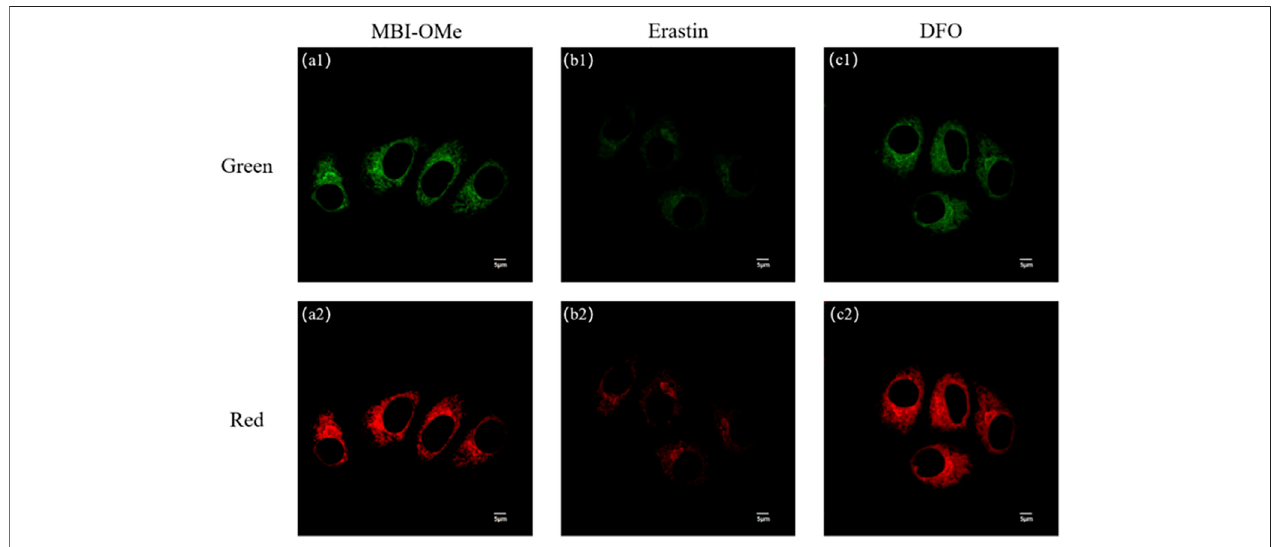
FIGURE 5 | (A) Imaging of MBI-OMe in HepG 2 cells. (B) Cell imaging of MBI-OMe performed after erastin (10 μ M, 6 h) was added to the cells. (C) Cell imaging of MBI-OMe after incubation with DFO (100 μ M, 6 h) under the condition of (B) . Green: 415 – 450 nm; Red: 460 – 560 nm; MBI-OMe: 30 µM.